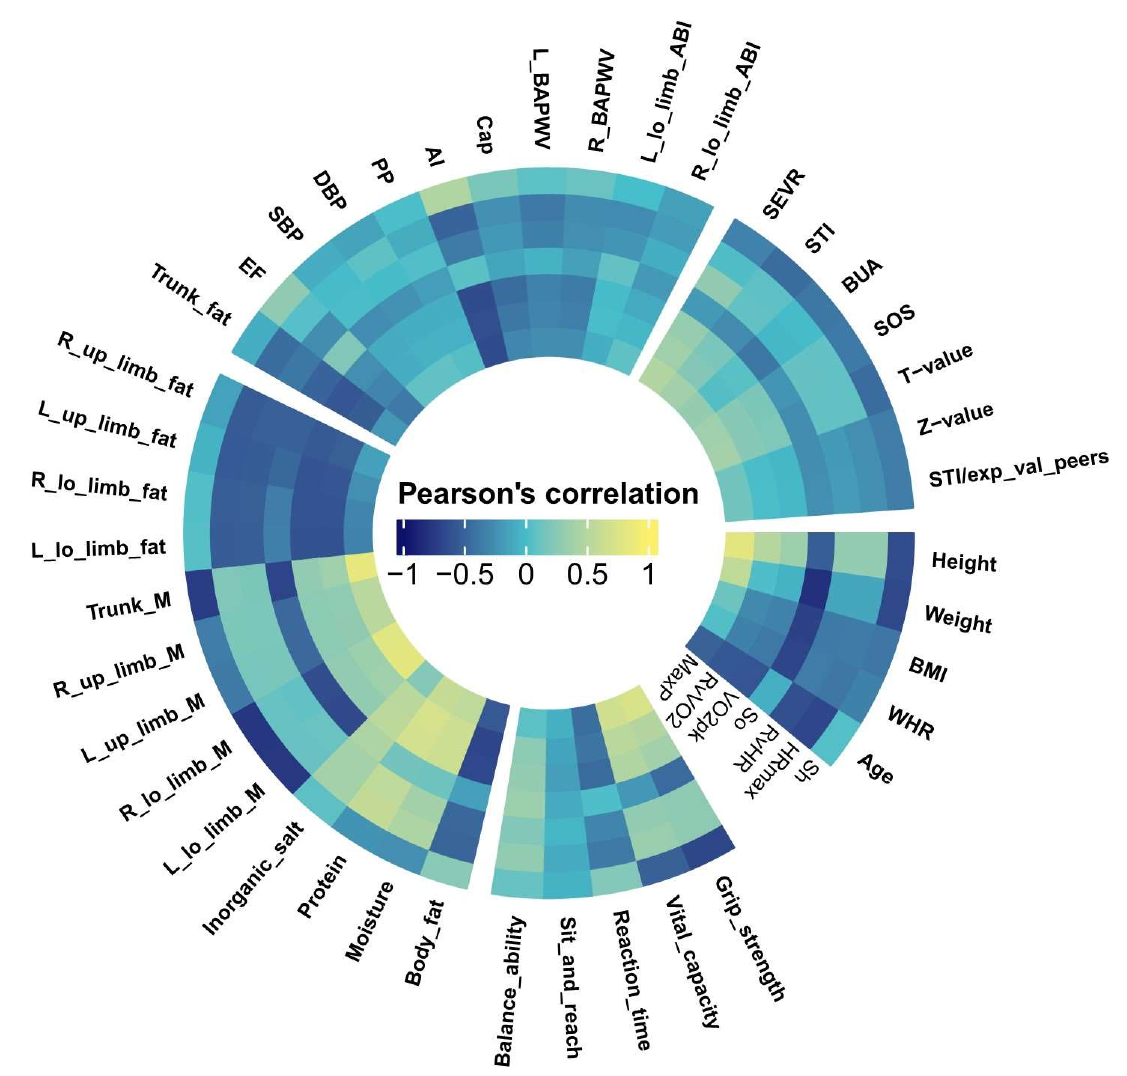
Figure 1. Relationships of all Non-In data with seven exercise data in cyclic heat map. The correlation data represented by each sector in the circle correspond to Table 1 and are divided into five main categories in the same way. Some variable names have been abbreviated for graphic aesthetics. R_, Right; L_, Left; lo_, lower; up_, upper; M, muscle; exp_val_peers, expected value of peers.